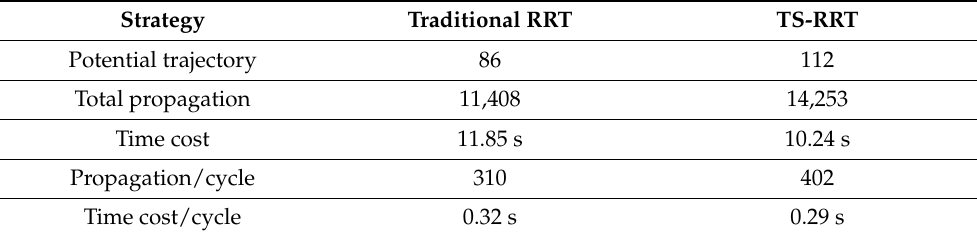
Table 3. Iterations and time consumed to generate the optimal track.